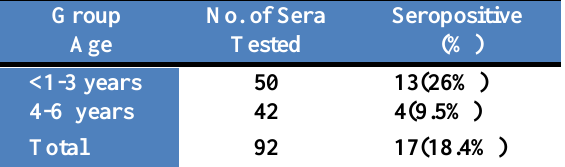
Table, 6: Prevalence of T.gondii in horses by using ELISA according to age group.